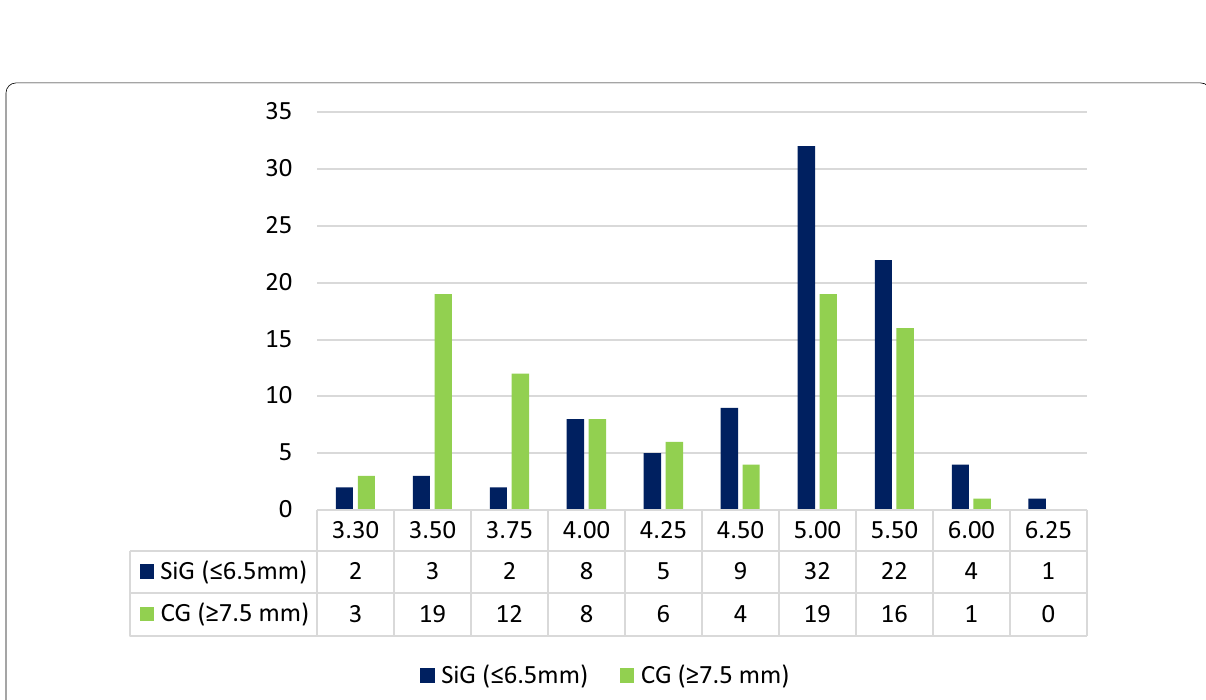
Fig. 3 Implant diameter. SiG (short implant group), CG (control